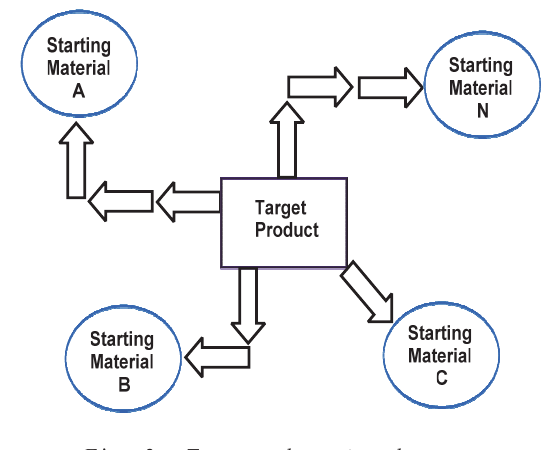
Fig. 3 – Target product-oriented